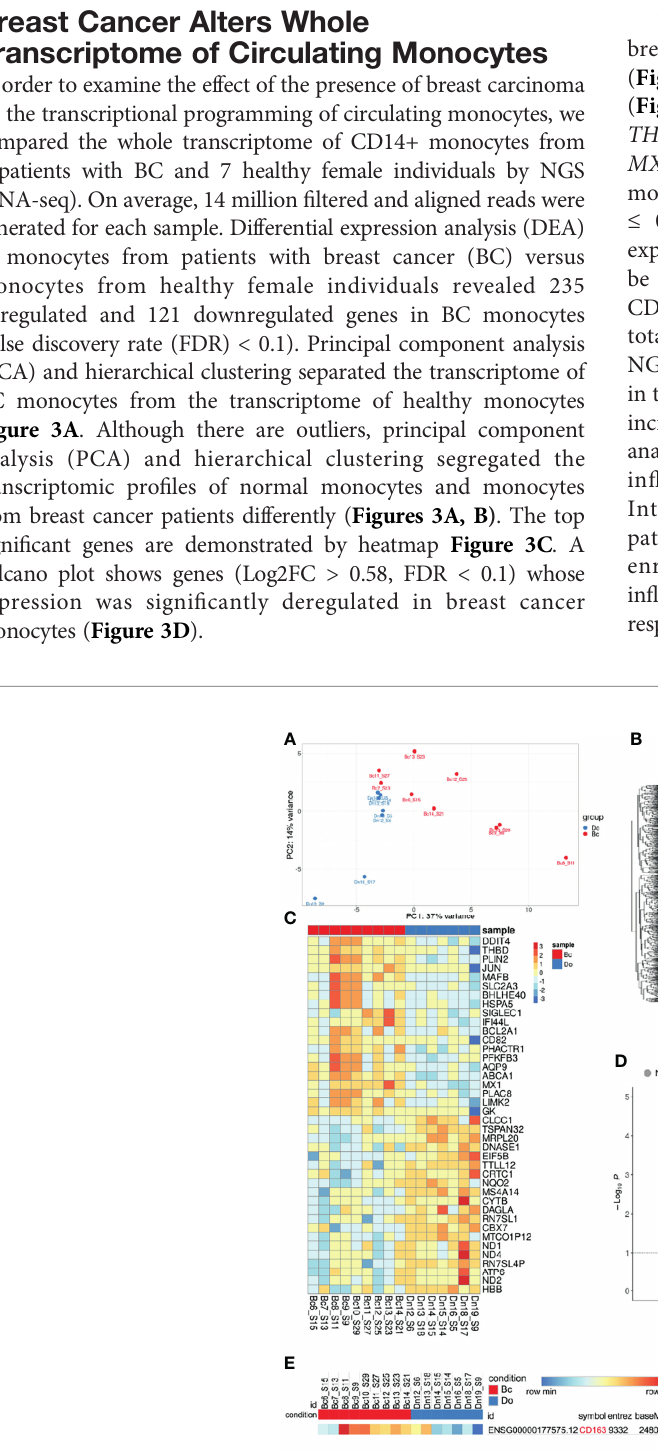
breast cancer group with lg2FC = 0.54 and p-adj = 0.036 ( Figure 3E ) and correlated with fl ow cytometry analysis result ( Figure 2 ). The top 20 upregulated genes such as DDIT4 , THBD , PLIN2 , JUN , MAFB , SIGLEC1 ABCA1 , C XCR4 , and